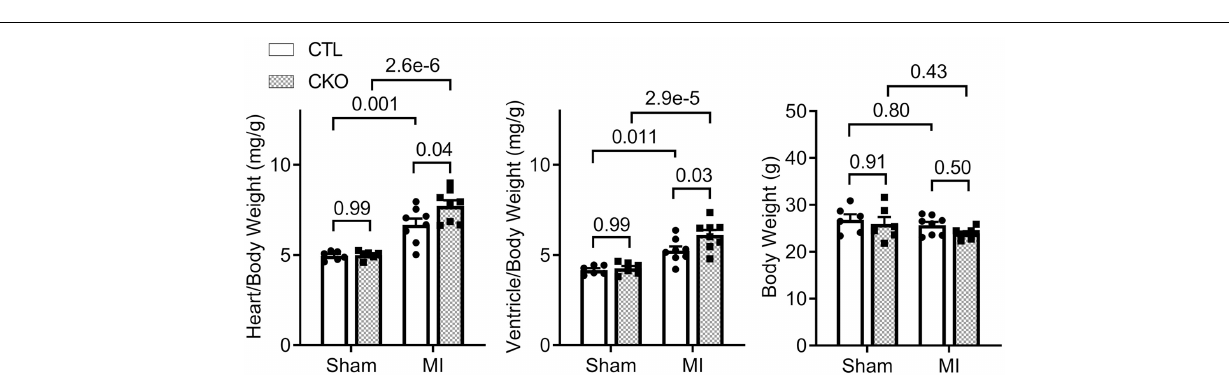
FIGURE 8 | Gravimetric data collected at 28 days post-MI. For sham groups, n = 6 mice (2 males and 4 females) for each genotype; for MI groups, n = 8 mice (3 males + 5 females) for each genotype. The p -value of the pair-wise comparison shown above each bracket is derived from two-way ANOVA followed by Tukey’s